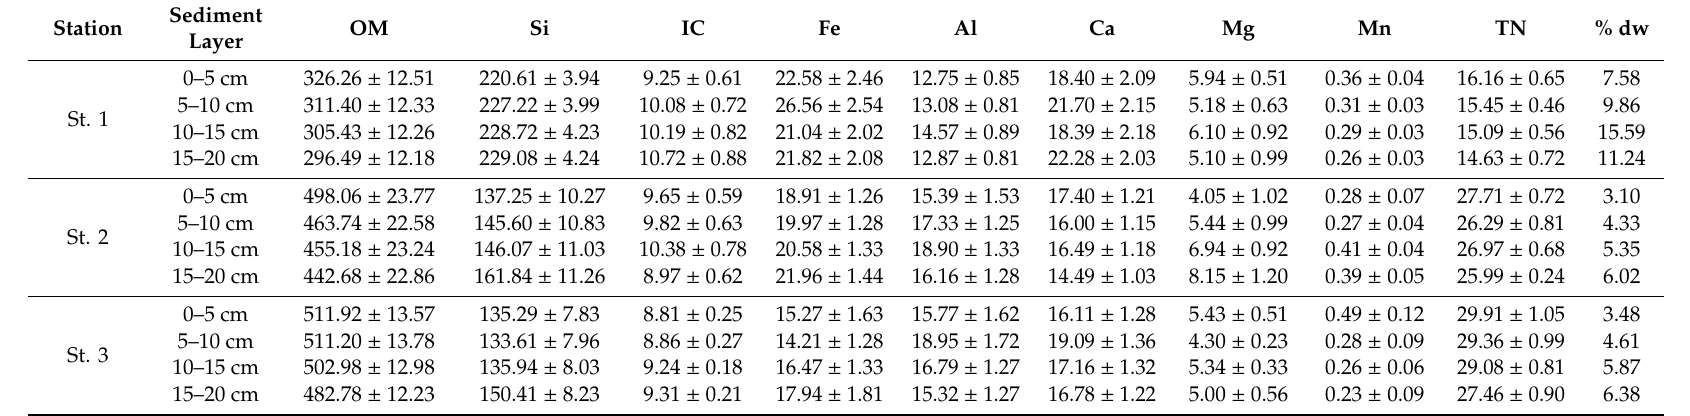
Table 4. The mean ( ± SD) values of main components of Długie Lake sediment (in mg g − 1